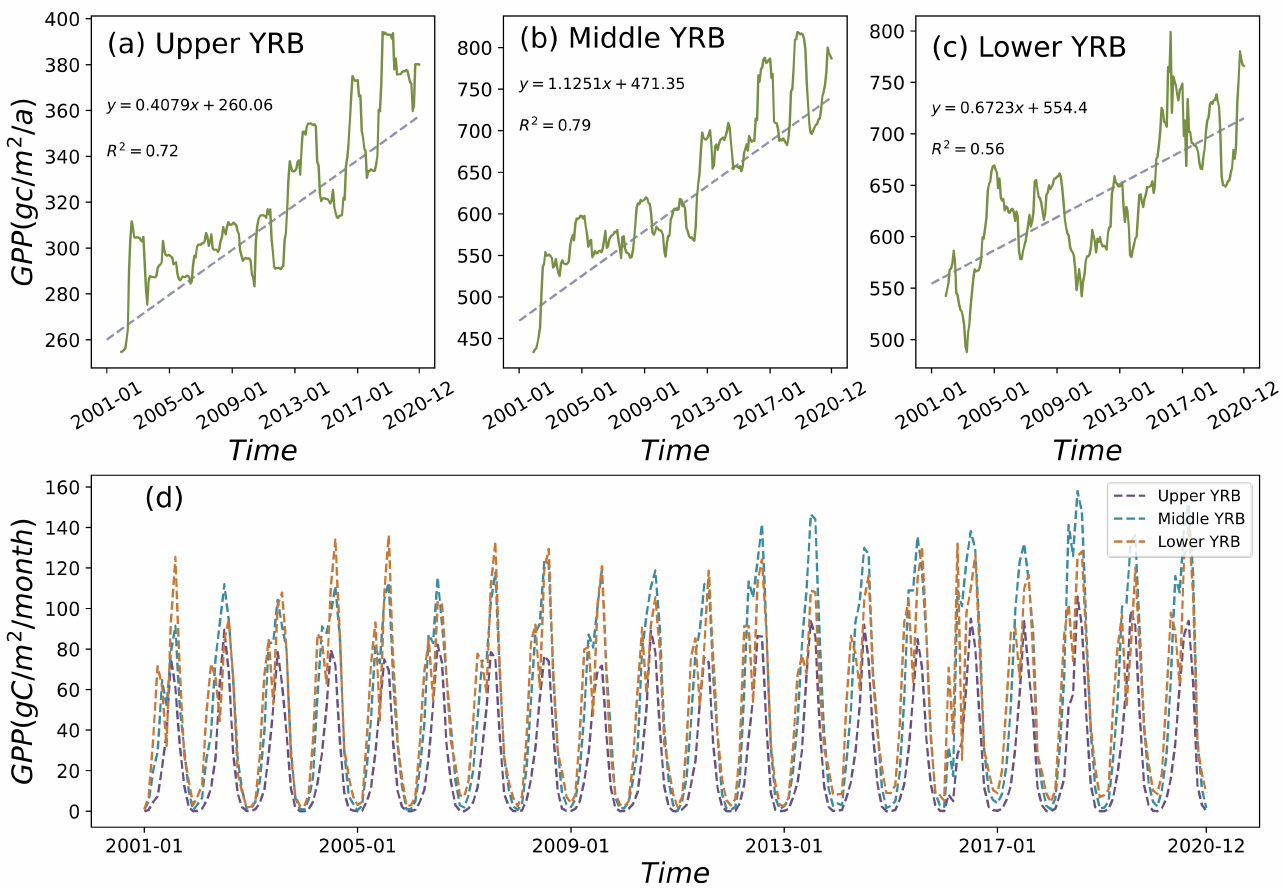
Figure A2. The annual ( a – c ) and monthly ( d ) variations in mean GPP values (sourced from MOD17A2H) in the sub-basins of the YRB; Upper YRB: ( a ); Middle YRB: ( b ); Lower YRB: ( c